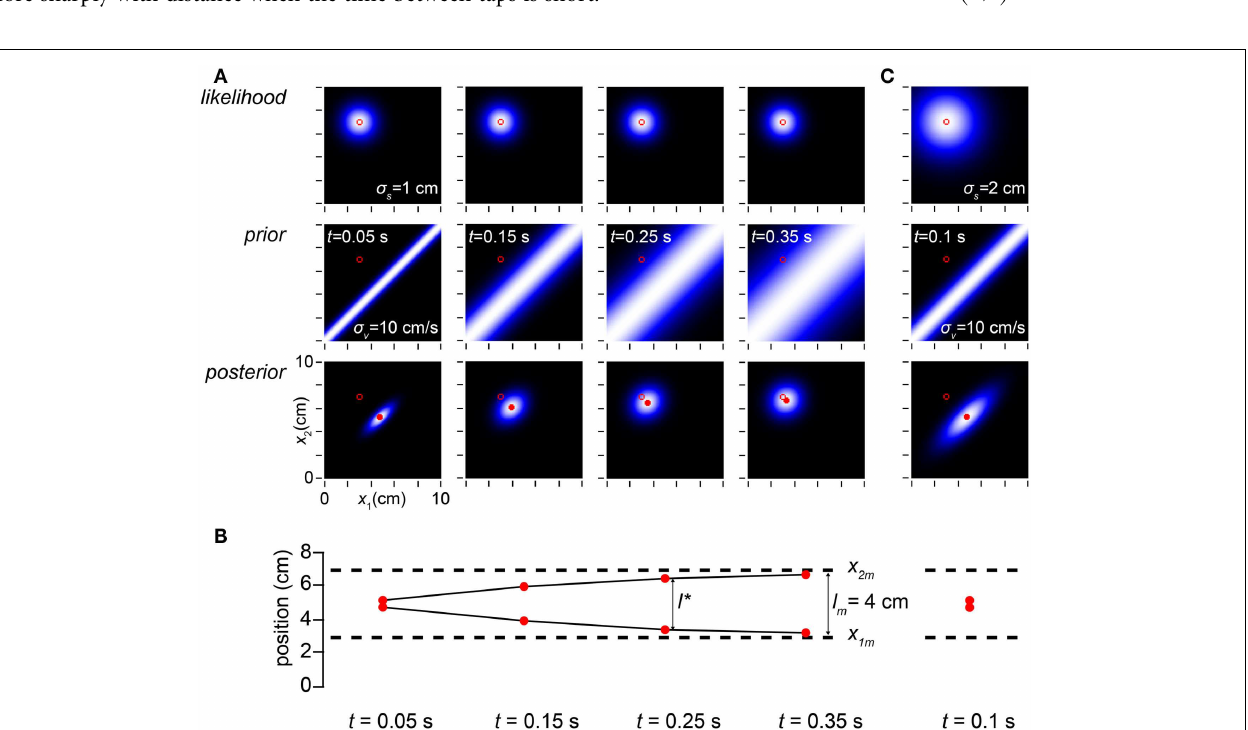
between filled and open circles in the posterior plots as t increases). For all columns, σ s = 1cm, σ v = 10cm/s. (B) The perceived first and second tap positions (filled red circles), corresponding to the mode of each of the posterior plots above, are graphed along with the measured tap positions (dashed lines).The perceived distance between taps asymptotically approaches the measured distance as t increases (compare to Figure 1C , lower). (C) The amount of perceptual length contraction depends not only on t and σ v but also on σ s . Here we simulate a trial at t = 0.1s for an observer whose spatial acuity is worse ( σ s = 2cm) than the observer in (A) . Although its posterior density is broader, this observer has the same percept (mode of the posterior) as the observer in (A) with t = 0.05s (leftmost column in A) . Note that the ratio of σ s to σ v t is identical ( = 2) in the two cases. It is this ratio that determines the amount of perceptual length